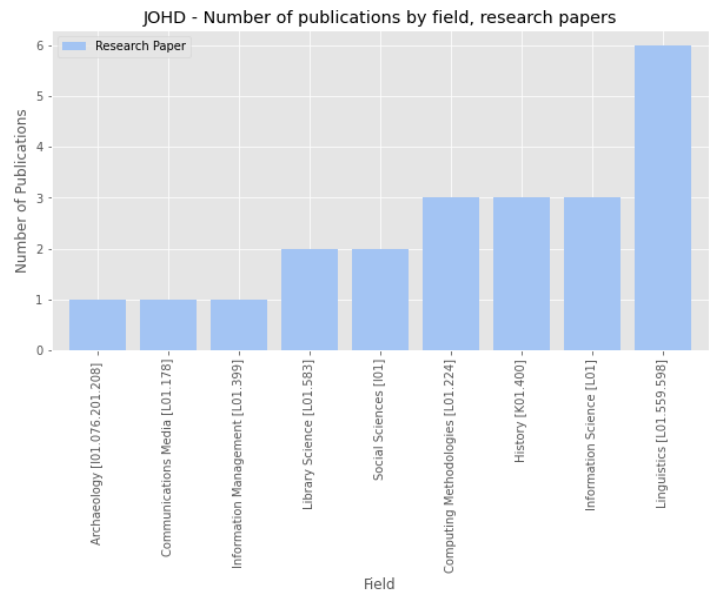
Figure A1. Number of publications by field, research papers (JOHD).